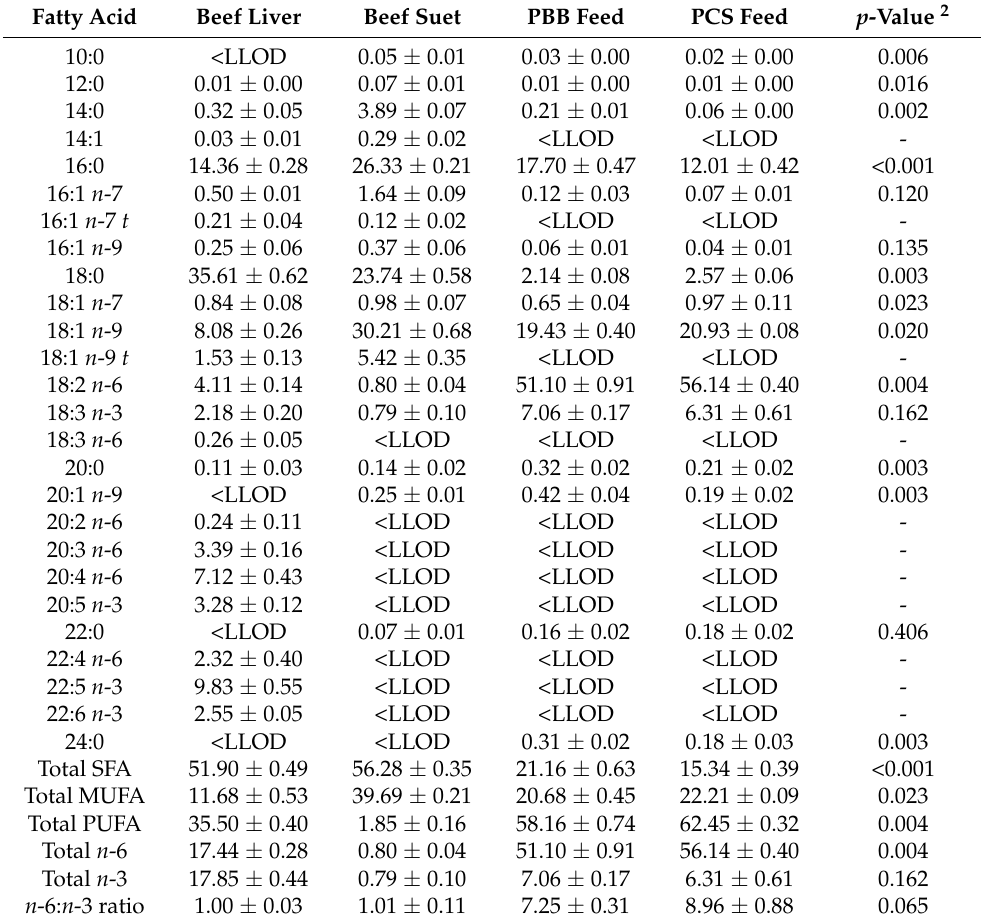
Table 2. Fatty acid profile of grass-fed beef by-products and layer hen feeds (% of total fatty acids) 1